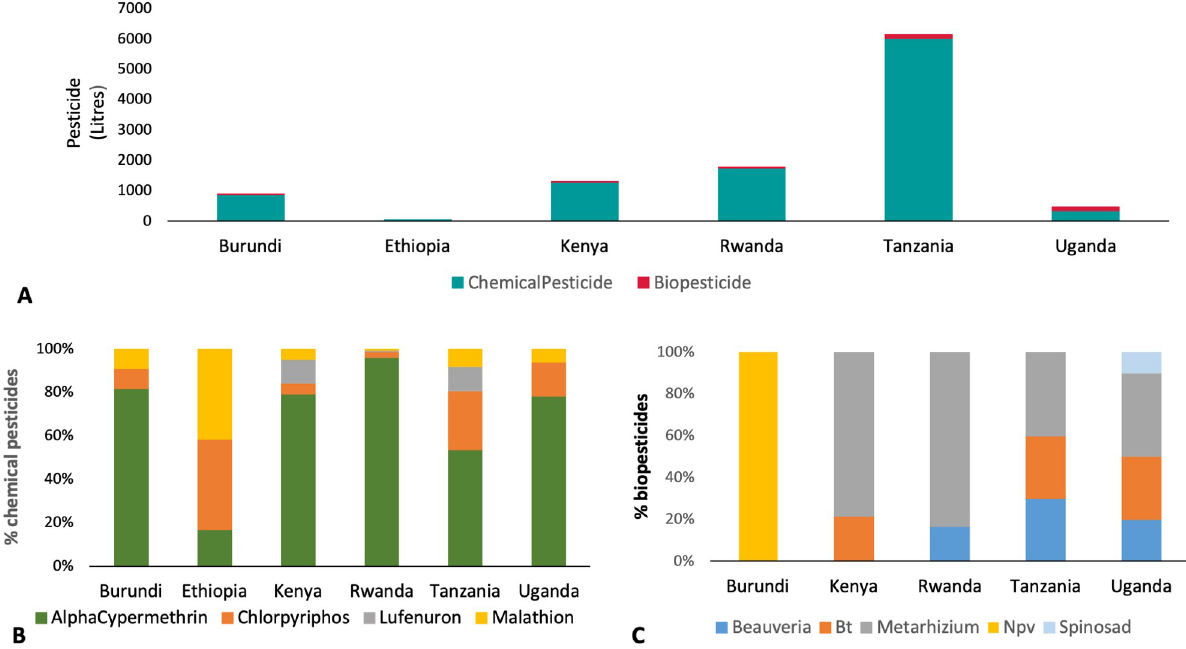
Fig 6. Quantity of different groups of pesticide use in fall armyworm management in eastern African countries (accumulating the quantity of all the pesticides that were recorded in liters for the six countries, individually, both for chemicals and biopesticides).